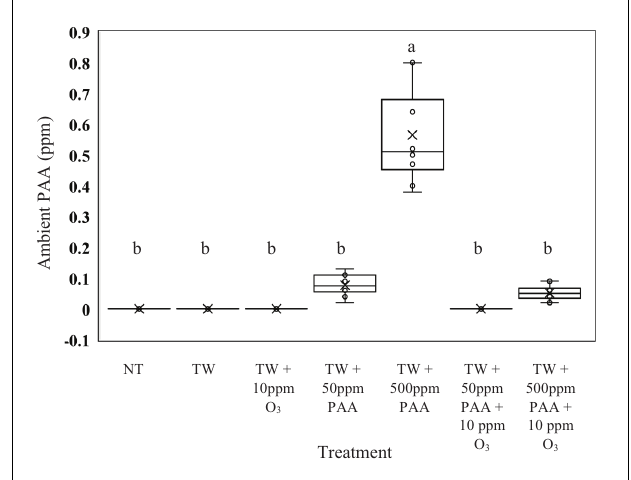
FIGURE 3 | The effect of applying PAA alone and in combination with aqueous ozone at 10 ppm on the mean log CFU/g of Campylobacter jejuni on whole hen carcasses 1 , 2 . Carcasses were inoculated with 10 6 CFU/mL of C. jejuni for a final attachment of 10 5 CFU/g of C. jejuni . Birds were then placed in a modified spray cabinet to be treated for 5 s (4 × ) via a low pressurized spray. Immediately after, birds were rinsed in 400 mL of nBPW and subsequently plated to determine load of Campylobacter . 1 N = 69, n = 10, P = 0.0006. 2 Means with different superscripts are considered significantly different (a,b).